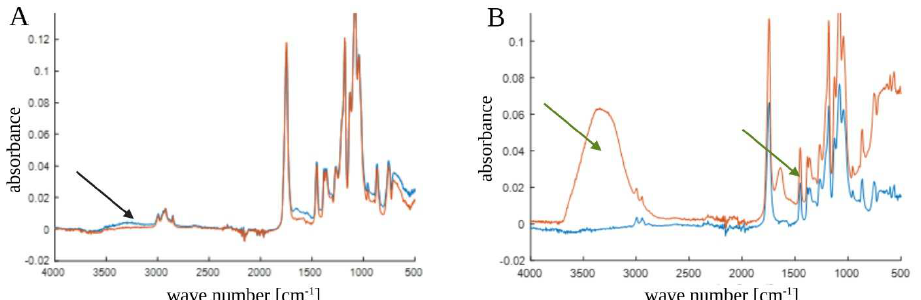
Figure 3. ( A ) Fourier transform infrared (FT-IR) spectrum of poly( ε -caprolactone) (PCL) samples. The black arrow indicates that there was no interaction in the ester group between the unsterilized PCL (blue line) and sterilized PCL (red line) samples. ( B ) FT-IR spectrum of PCL compounded with beta-tricalcium phosphate 20% (PCL+β-TCP 20%) samples. The green arrows indicate the interactions in the ester group between the unsterilized composite (blue line) and the sterilized composite (red line) samples.